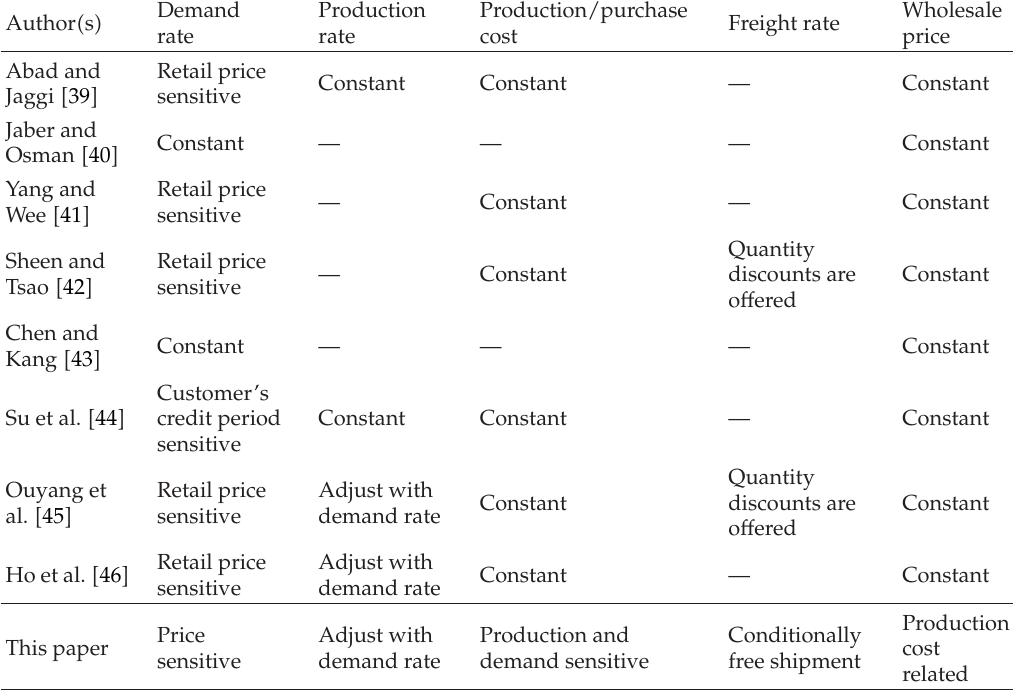
Table 1: Comparison between the papers discussing integrated inventory model with a trade